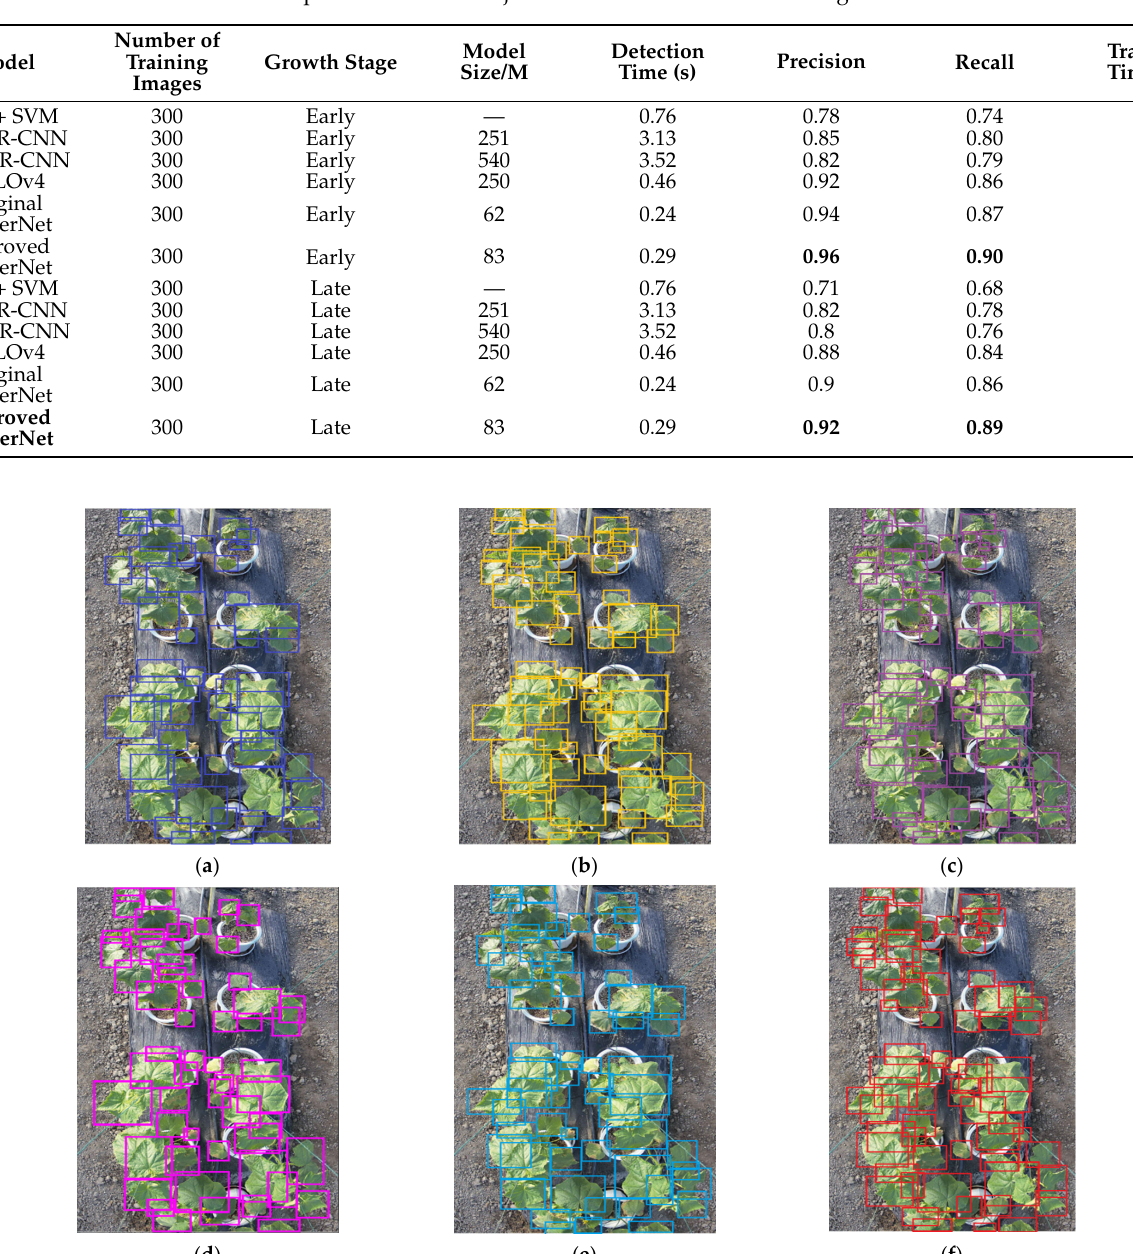
Figure 8. Visual effects of six leaf detection methods on the late stage of cucumber: ( a ) ExG + SVM; ( b ) Mask R-CNN; ( c ) Faster R-CNN; ( d ) YOLOv4; ( e ) original CenterNet; ( f ) the improved CenterNet.